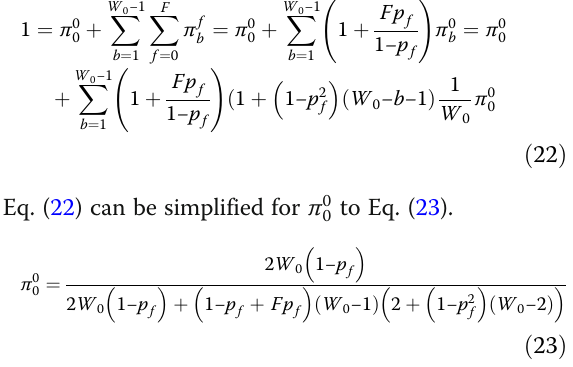
The vehicular node transmits in the next slot after the backoff counter becomes zero. Hence, the stationary transmission probability in a slot can be calculated by Eq. (24).